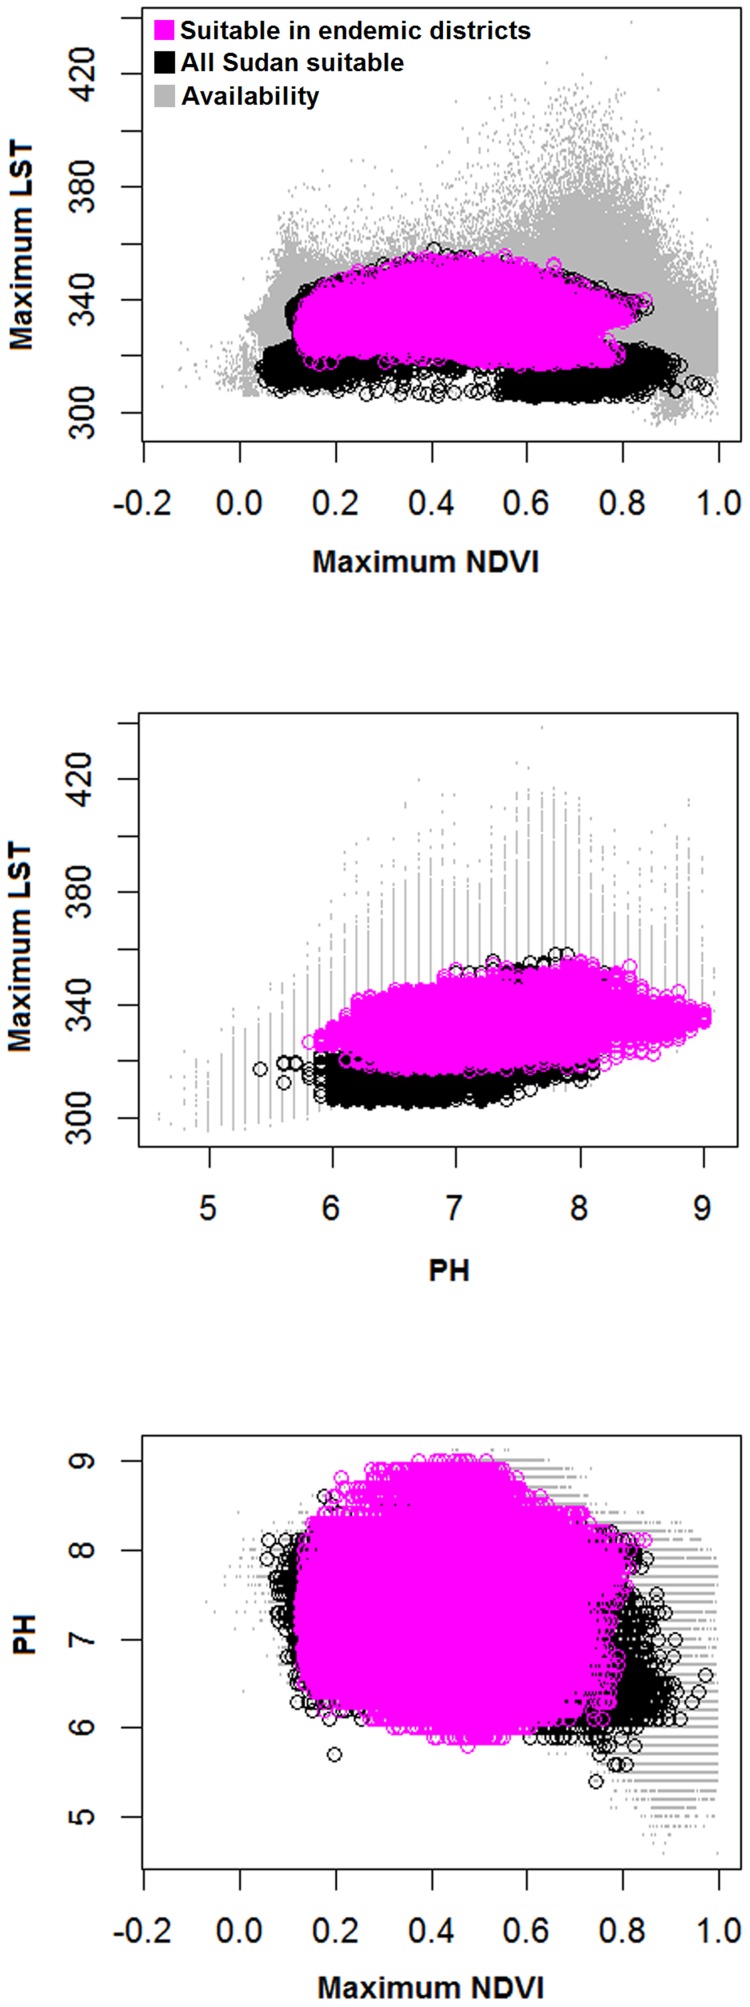
Visualization of mycetoma ecological niches (i.e., the set of environmental values under which the species can potentially maintain populations) in two-dimensional environmental spaces based on different environmental variables.The diagram shows the entire environmental availability across Sudan and South Sudan (light gray color), and conditions identified as suitable across Sudan and South Sudan (black color) and across endemic districts (pink).